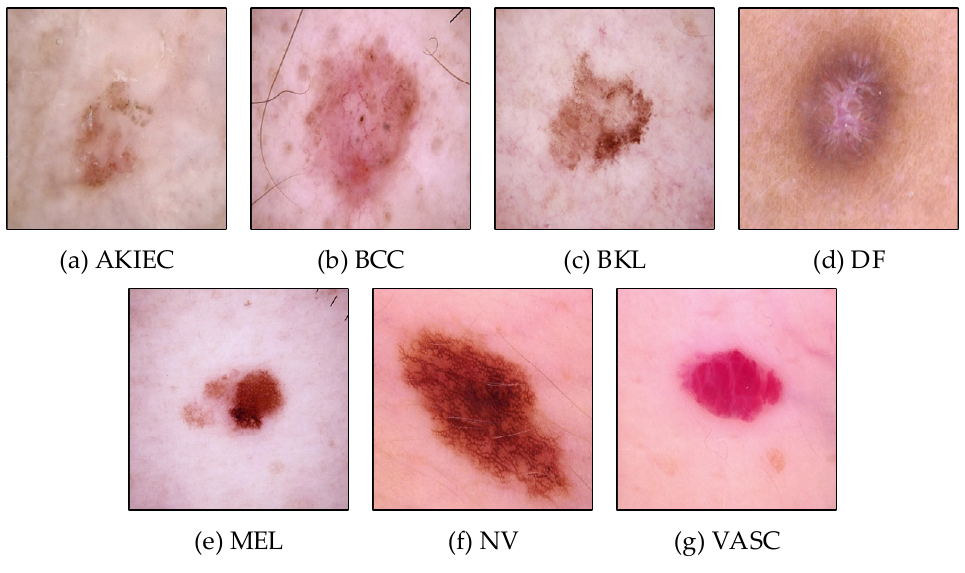
Figure 6. Sample images of the seven skin diseases. Table 1. The number of images for each class of skin disease in the test set for the two partitions.